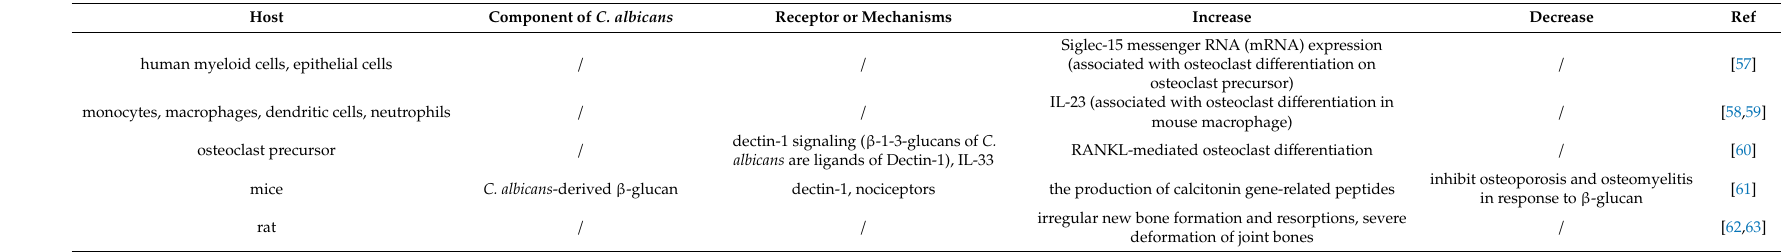
Table 3. Myeloid cells a ff ected by Candida albicans